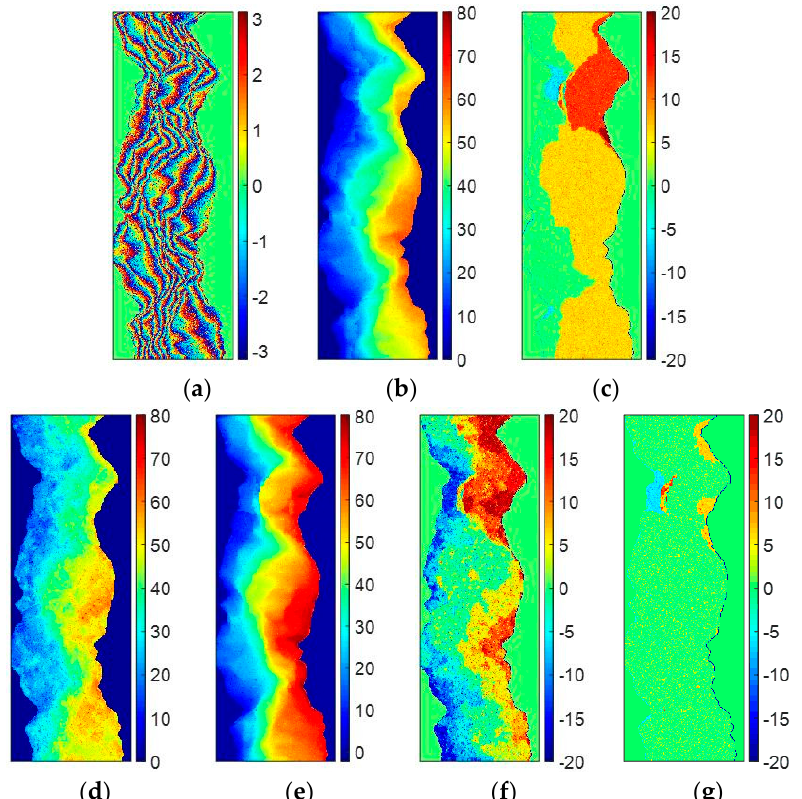
Figure 5. ( a ) Simulated wrapped phases of Figure 1b (coherence coefficient is 0.75). ( b ) PU results of ( a ) obtained by PUMA (clique potential exponent is 0.5). ( c ) Errors between Figure 1b and PU results ( b ). ( d , e ) PU results of ( a ) obtained by ( d ) DB TSPA-PUMA and ( e ) MB TSPA-PUMA. ( f , g ) Errors between Figure 1b and PU results ( d , e ).